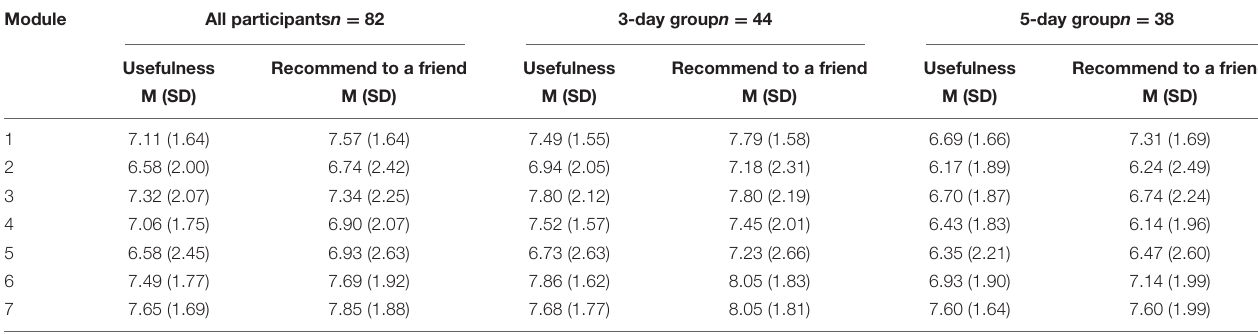
TABLE 8 | Satisfaction of each module.